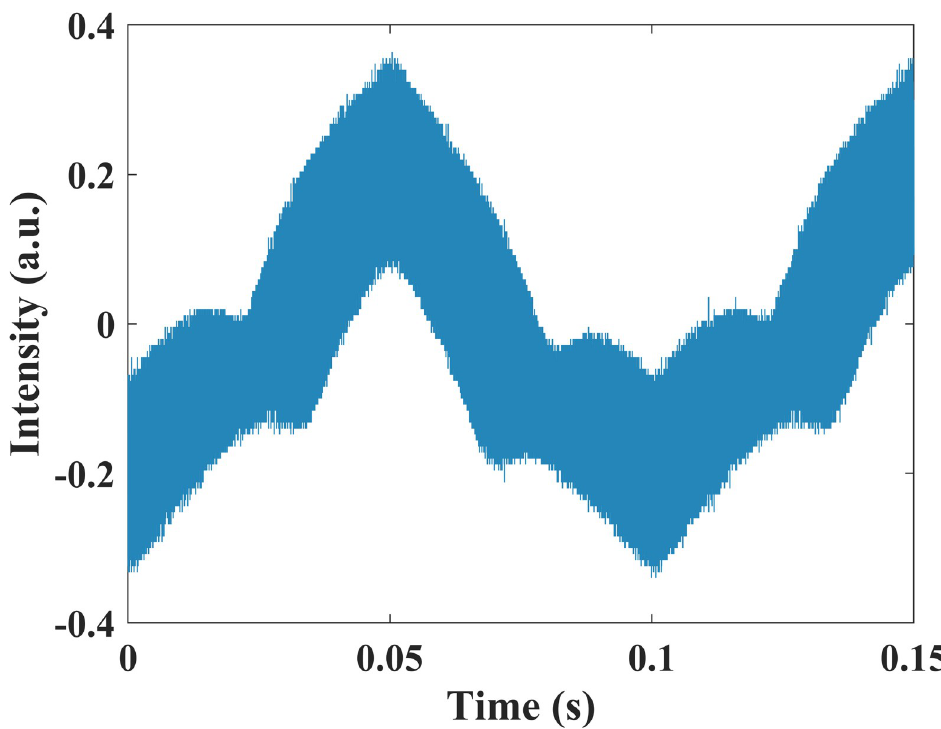
Fig 7. The transmitted light intensity signal.